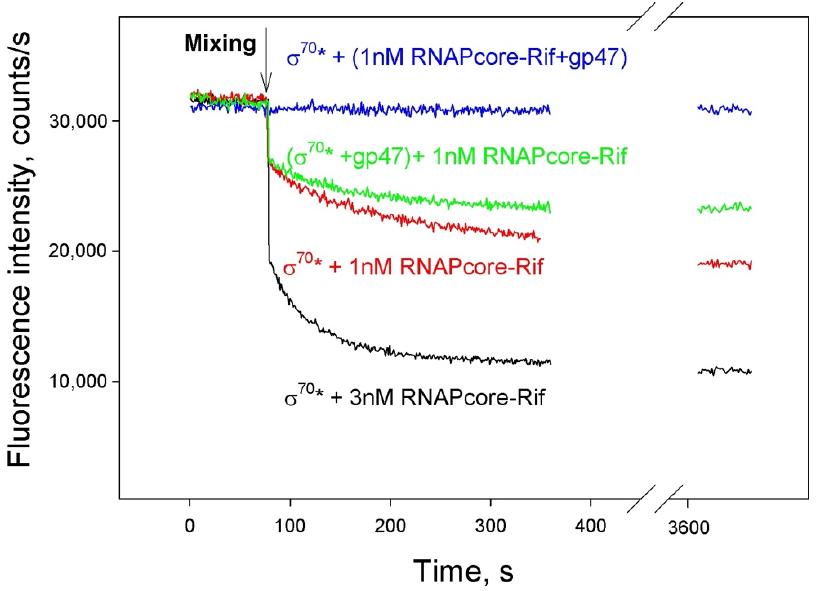
Figure 4. Binding of SaPh711_gp47 to E. coli RNA core enzyme . The affinity of gp47 for E. coli RNAP core enzyme was evaluated by a real-time fluorometric competition binding assay using a derivative of the E. coli RNAP σ 70 subunit labeled with fluorescein ( σ 70 *) as a reference competitor. Shown are time dependences of the decrease in fluorescence of the RNAP core–Rif complex upon the addition to σ 70 * in the absence (black and red curves) and in the presence (blue and green curves) of gp47. Black curve shows decrease in σ 70 * fluorescence upon the formation of the holoenzyme, since rifampicin is quenching the fluorophore. Red curve shows that σ 70 * fluorescence quenching depends on the ratio of core and σ 70 *. The blue curve shows the lack of decrease in σ 70 * fluorescence upon the addition of RNAP core preincubated with gp47 to σ 70 *. The green curve shows time dependence of the decrease in fluorescence upon the addition of RNAP core to premixed σ 70 * and gp47. The concentrations of σ 70 *, gp47 and RNAP core were 1.5 nM, 12 nM and 1 or 3 nM, respectively, unless otherwise